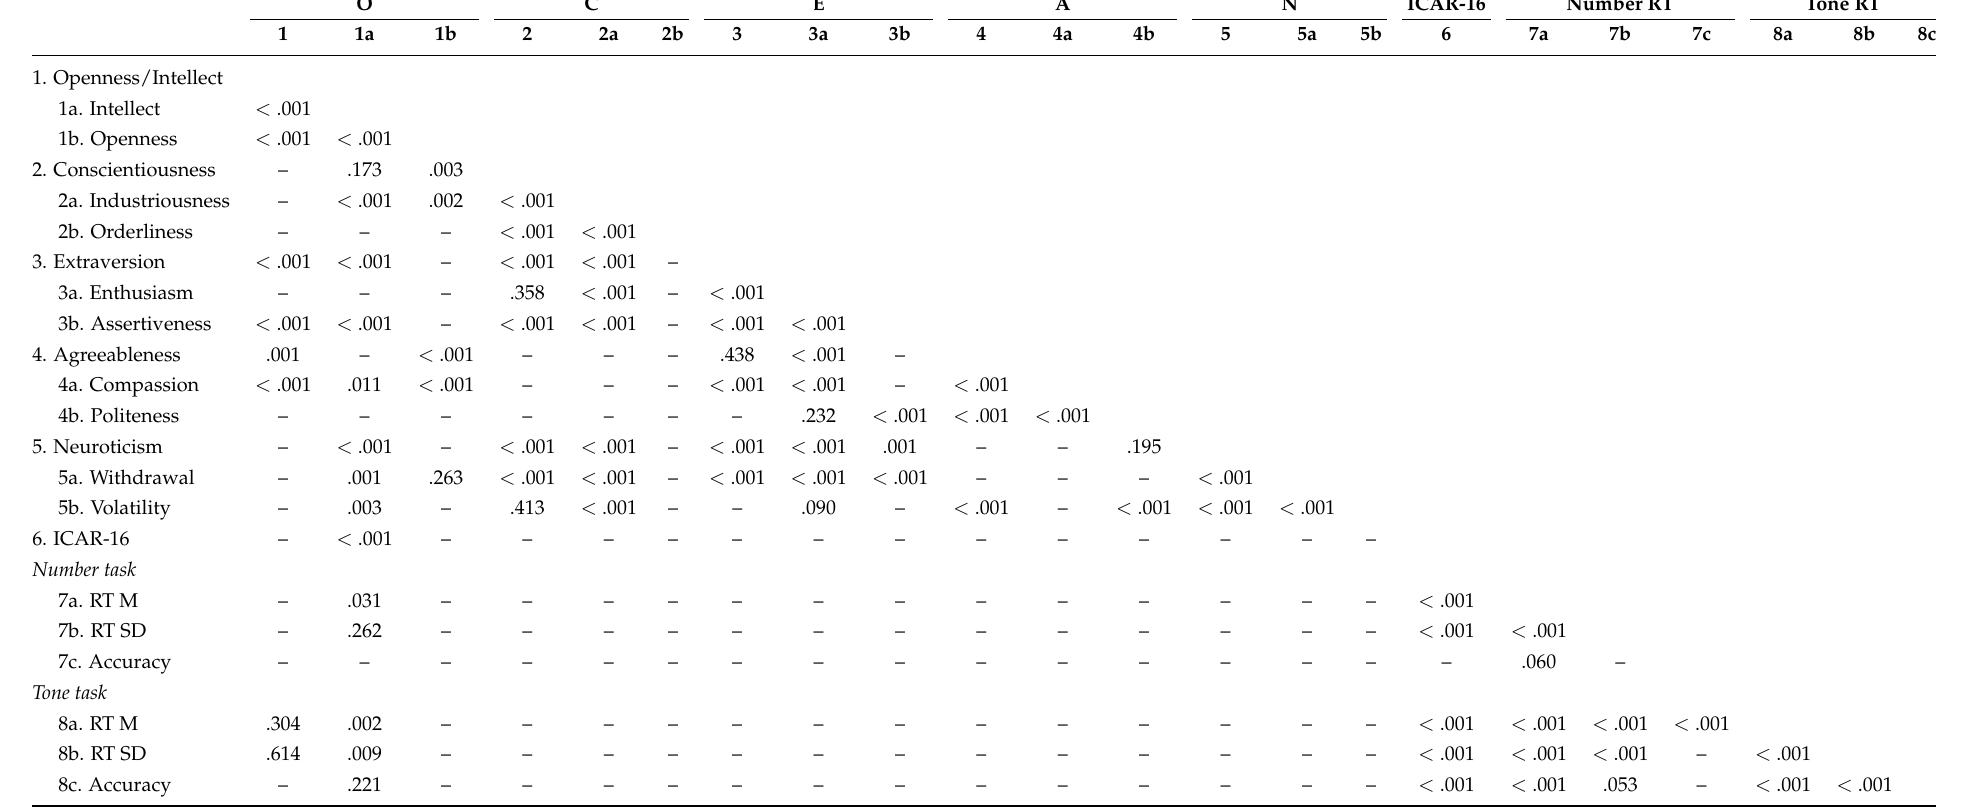
Table A3. Matrix of Bonferroni-corrected p -values from pairwise correlations shown in Table 5. O